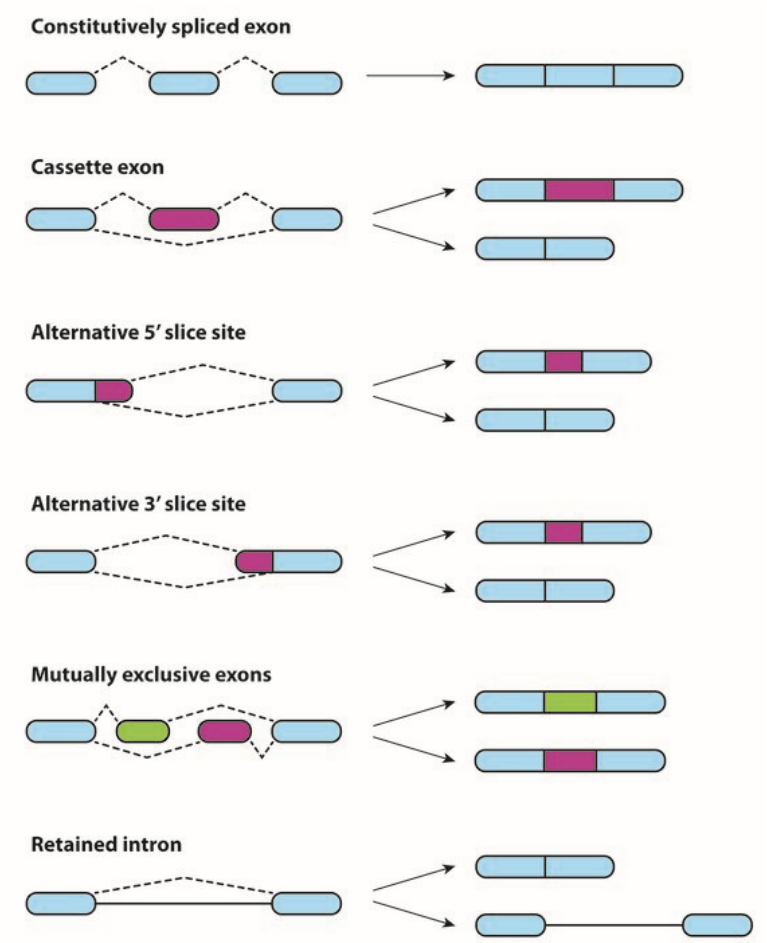
Figure 1. Different types of AS events. Constitutive splicing, exon skipping, alternative 5 ′ and 3 ′ sites, mutually exclusive exons, and intron retention are shown. The pre-mRNAs are shown above the arrows; the mature mRNA variants following AS are shown below the arrows.